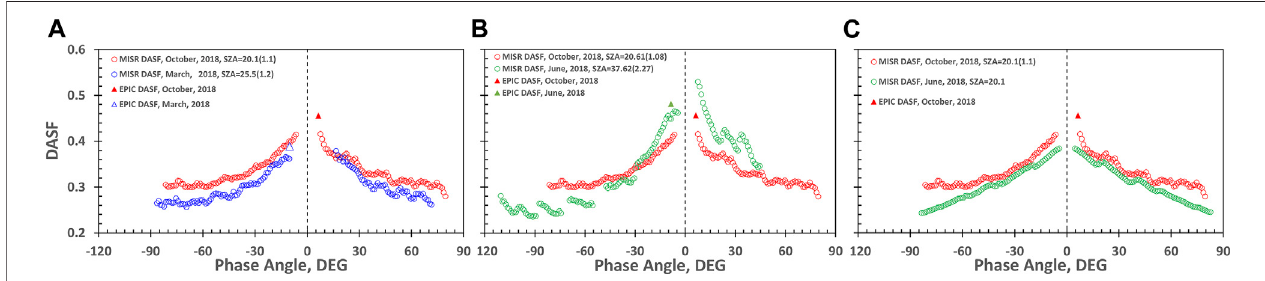
FIGURE 11 | Changes in MISR (circles) and EPIC (triangle) DASFs of Amazonian central rainforests from October to March (A) , from June to October (B) and transformation of EPIC DASF in June to sun-sensor geometry in March (C) . Numbers in parentheses in legends show std of solar zenith angle. Relative difference between MISR and EPIC DASFs is below 8%. Values of NRMSE between MISR DASF and its modeled counterpart do not exceed 9%.